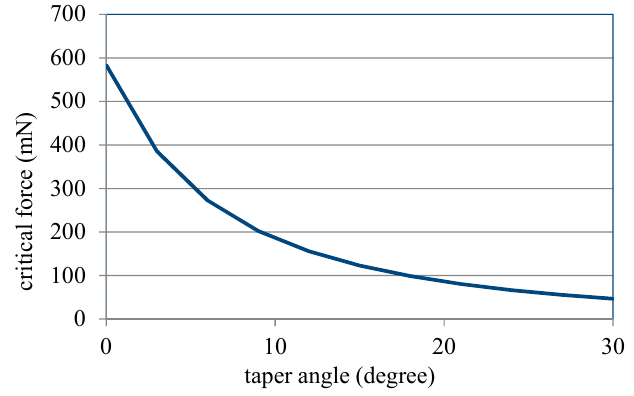
Figure 7. Relationship between the taper angle of ASSM and critical force calculated from Equation (10).